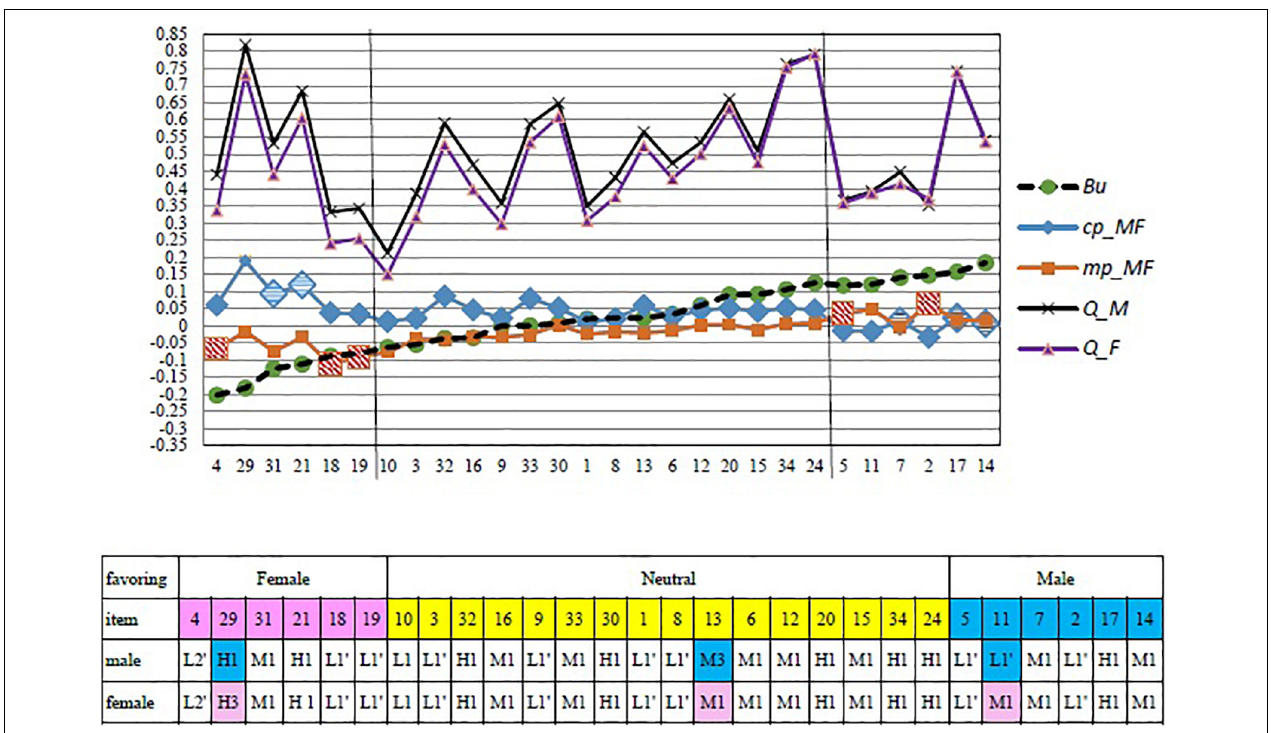
FIGURE 3 | Differential item functioning (DIF) predicted by mp and cp indices and classifications for favoring